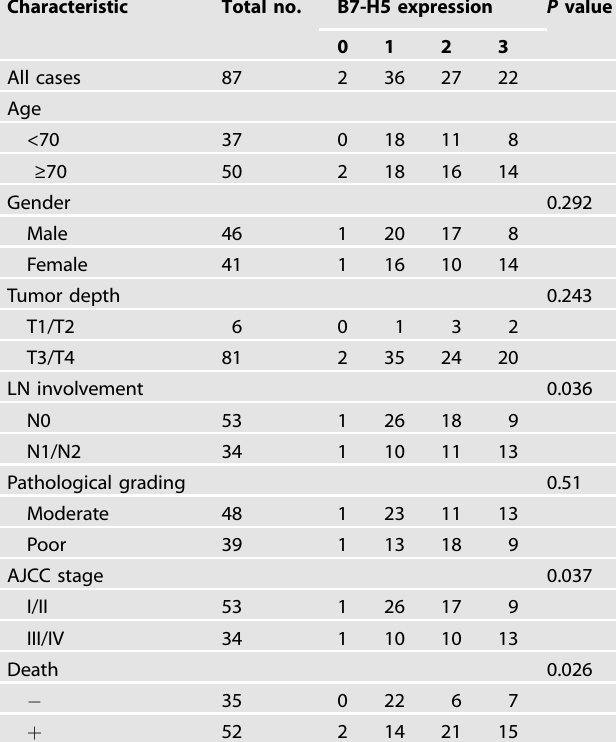
Table 1. B7-H5 expression and clinical features in 87 colorectal cancer patient samples. Total